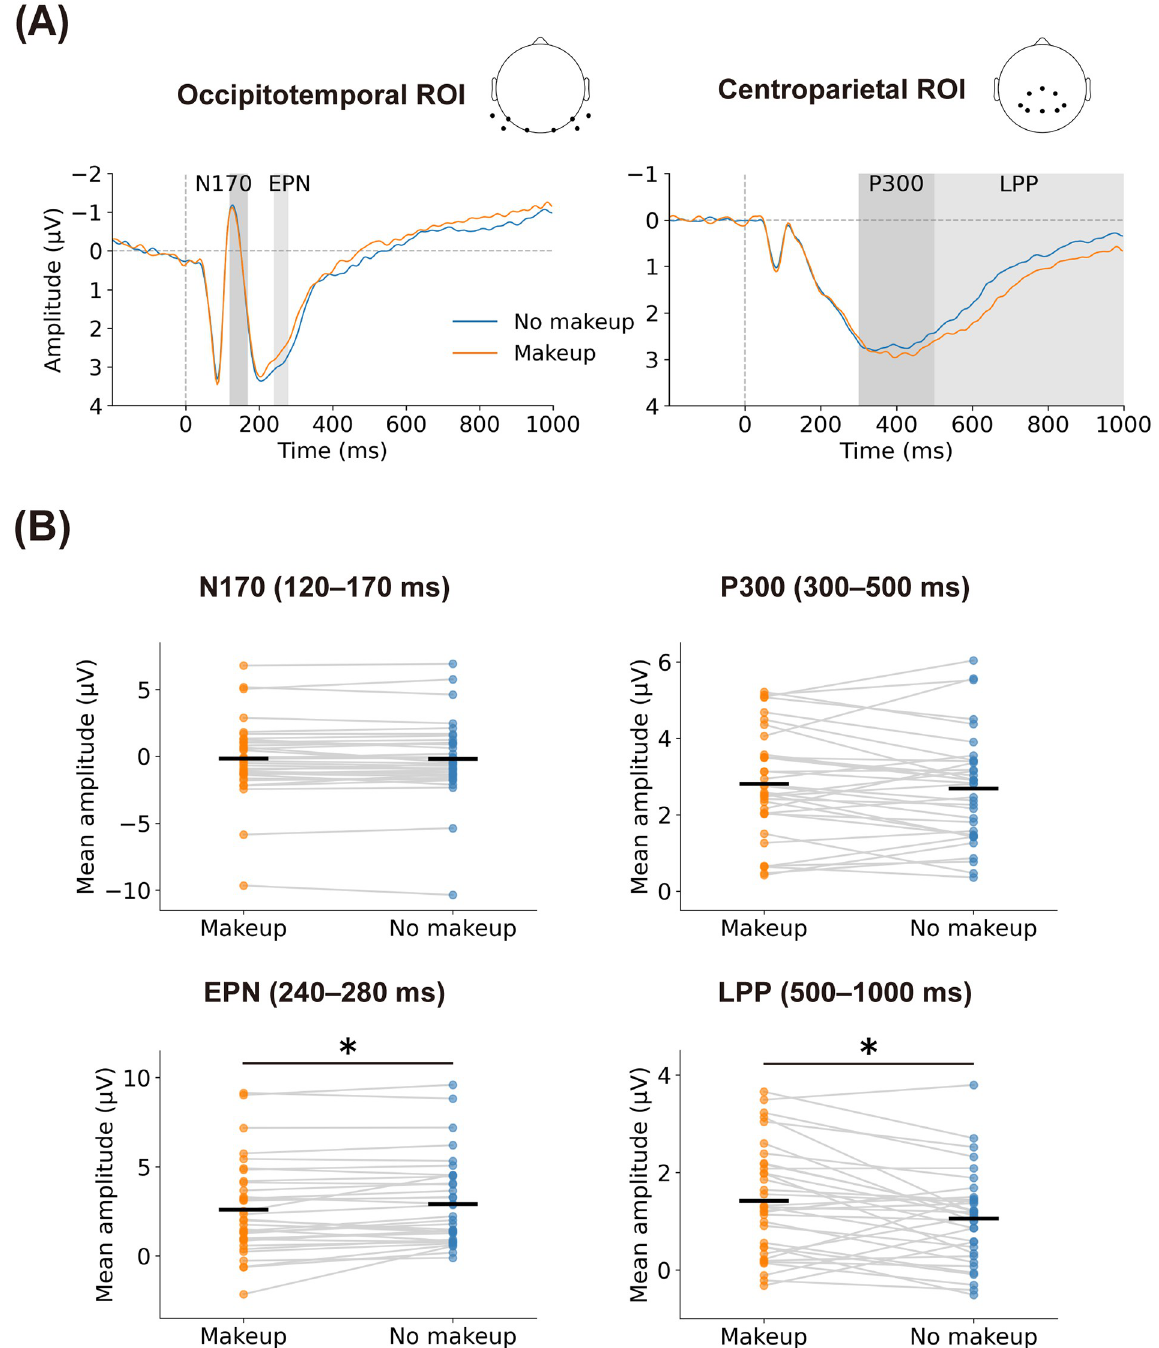
Fig 2. ERP results in Experiment 1. Panel A shows the grand average ERP waveforms elicited by facial images in the occipitotemporal ROI and centroparietal ROI. Panel B shows repeated measures plots visualizing amplitudes of the N170, EPN, P300, and LPP components for the conditions (makeup vs. no makeup). Horizontal black lines represent the mean amplitudes for each condition. Asterisks indicate a significant difference between the conditions determined by a paired t -test ( p < 0.05). ERP, event-related potential; ROI, region of interest; EPN, early posterior negativity; LPP, late positive